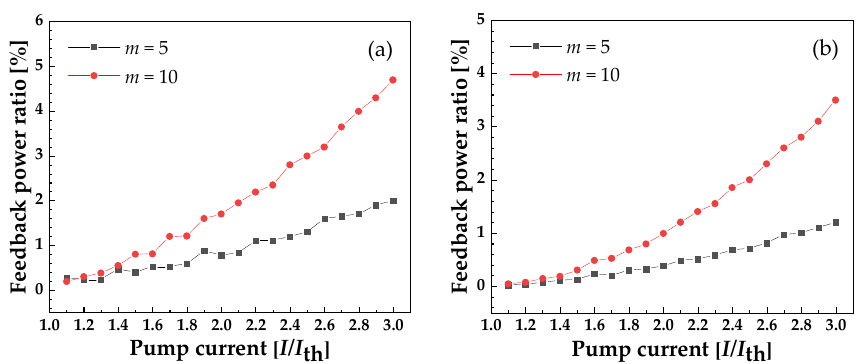
Figure 6. Hopf bifurcation point vs. bias current. ( a ) τ f = 2.0 ns, ( b ) τ f = 2.4 ns.